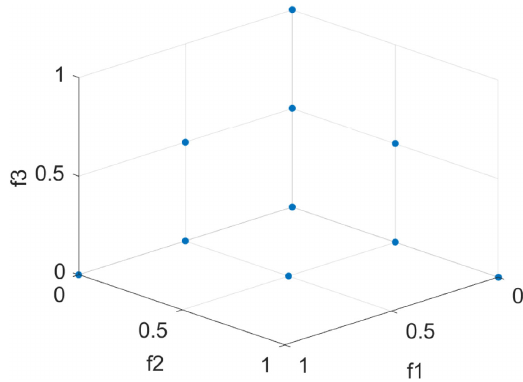
FIG. 1. The distribution of the reference points of a five- objective problem with p ¼ 2 in the space constituted by any three of the five objective